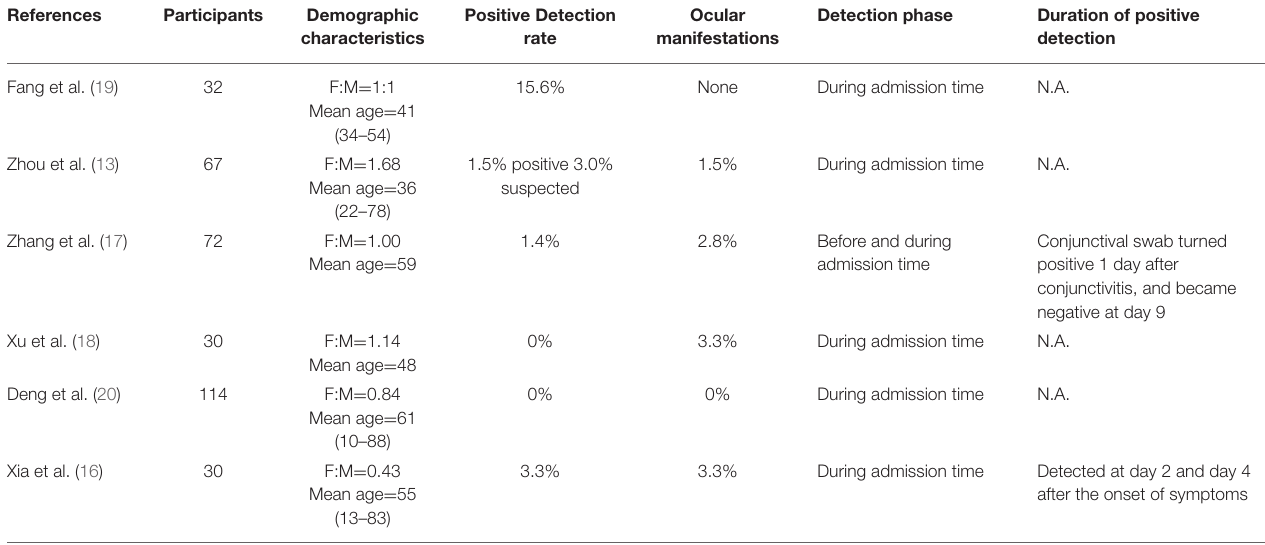
TABLE 2 | Summary of reviewed articles for the detection of SARS-CoV-2 in tears or conjunctival